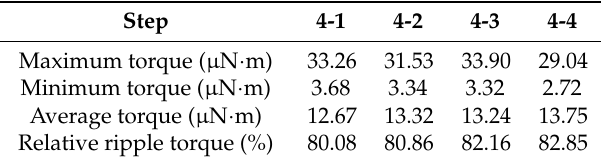
Table 5. Step 4: Comparison of the torque characteristics of each step.